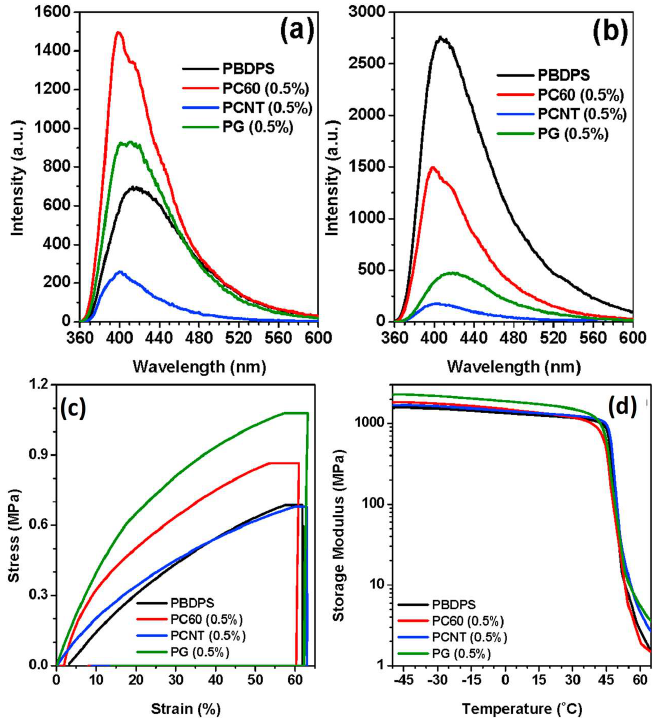
Figure 4. Liquid-crystalline polyesters reprocessed with various carbon